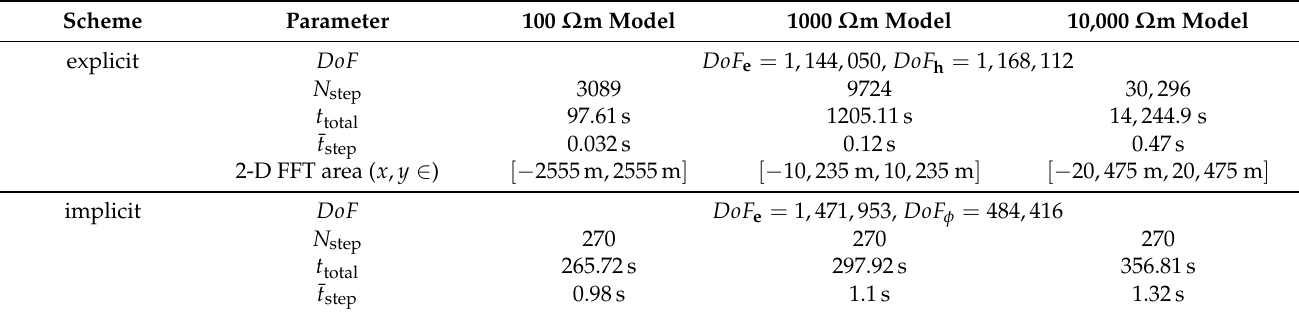
Table 1. Example 3: comparison of forward modeling speeds between explicit and implicit schemes.